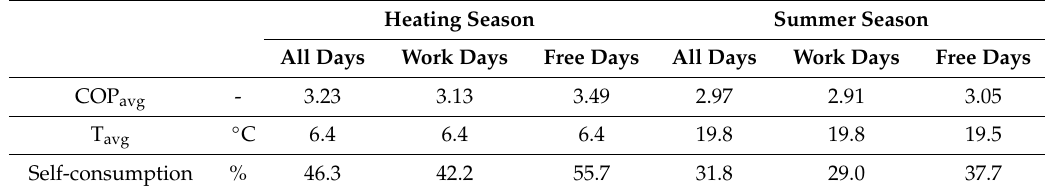
Table 7. Calculation parameter for season